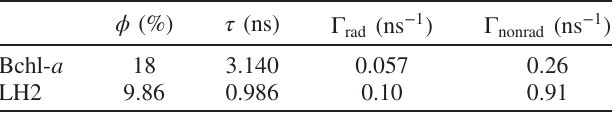
TABLE I. Single-pigment vs aggregate fluorescence. Quantum yield of fluorescence ( ϕ ) and decay lifetime ( τ ) of isolated Bchl- a molecules and LH2 complexes, together with their radiative ( Γ and nonradiative ( Γ ) decay rates (adapted from Ref. nonrad